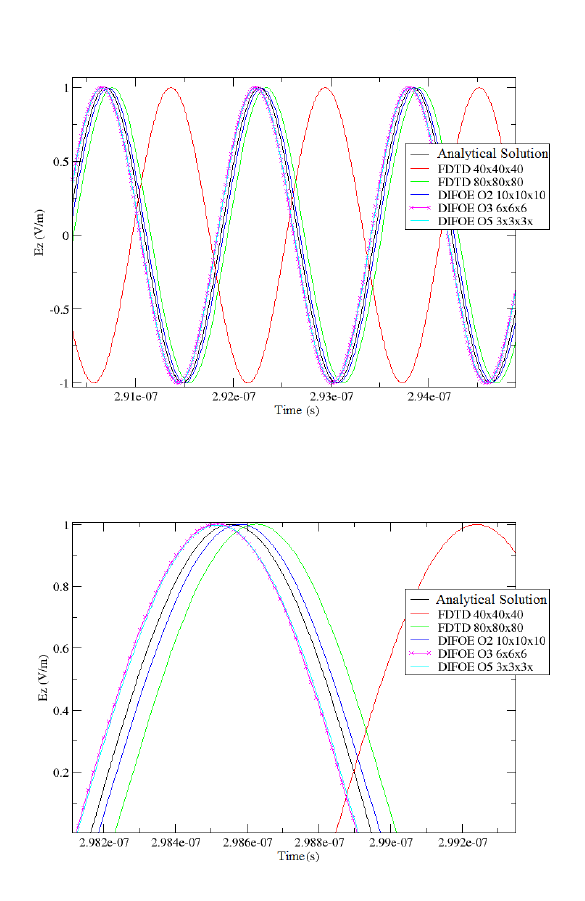
Figure 2: Comparisons between FDTD and our method for various meshes and orders at a point inside the cavity.